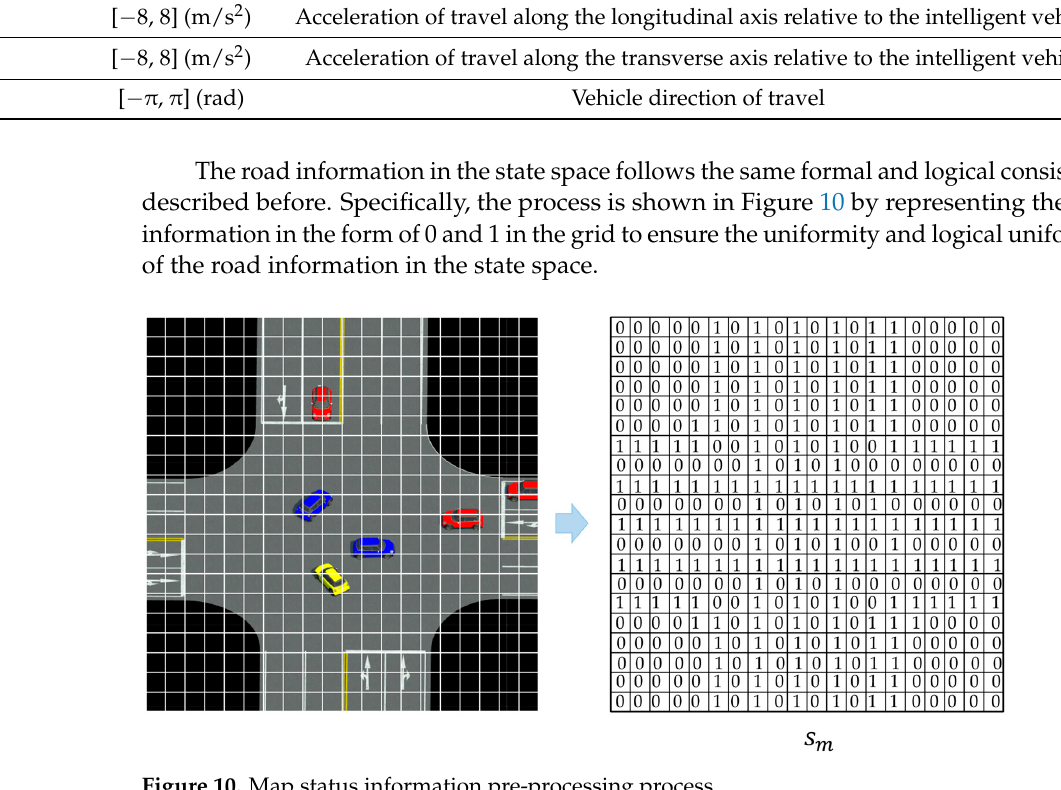
Figure 10. Map status information pre-processing process.